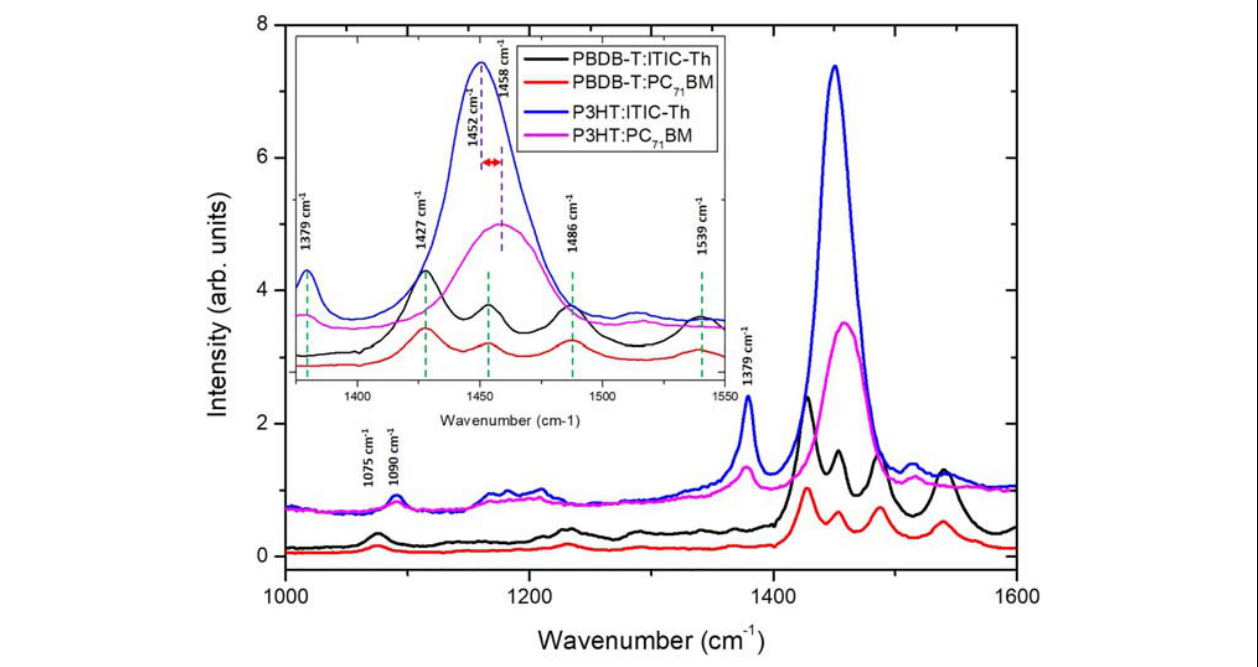
FIGURE 4 | Comparison of Raman spectra for thin films of various D:A